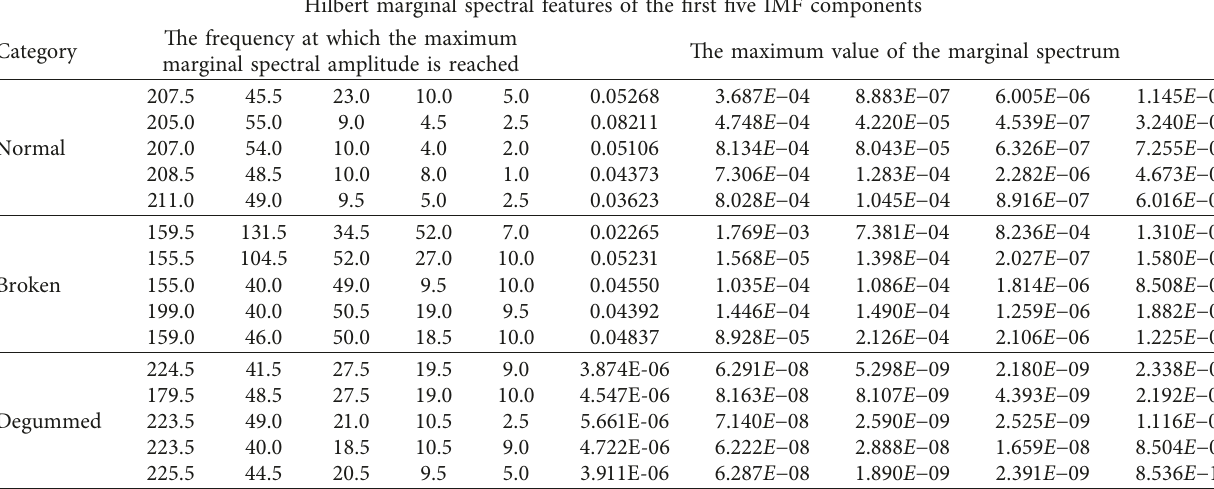
Table 2: Hilbert marginal spectral characteristics of three types of piezoelectric patch